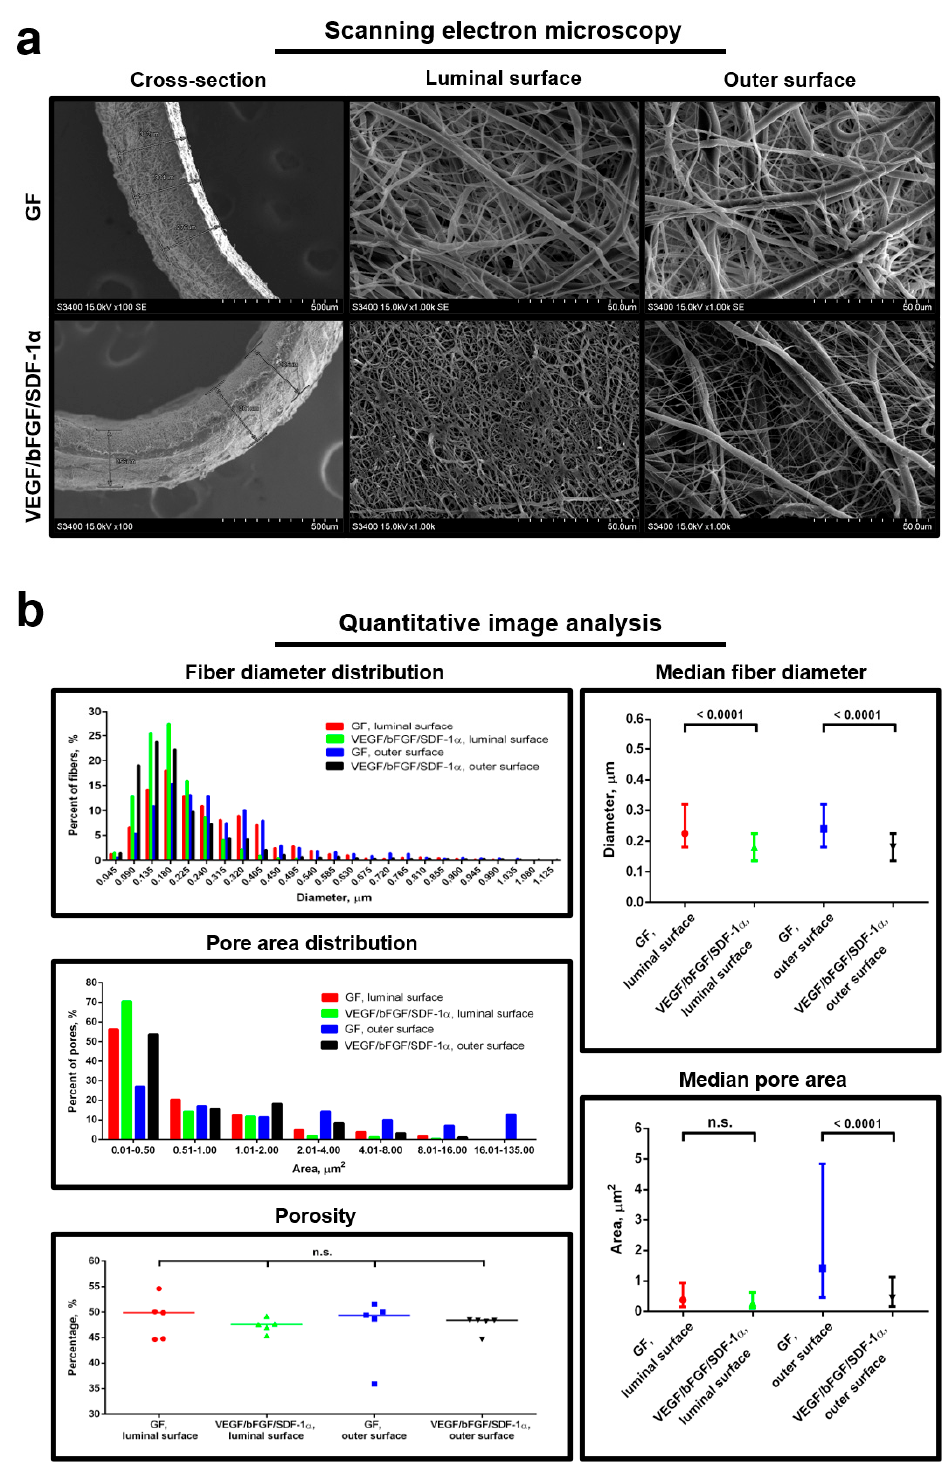
Figure 1. Two-layer structure of the grafts scales down the topography of the fibers and pores. ( a ) Pre-implantation representative scanning electron microscopy images of the grafts modified exclusively with either VEGF, bFGF or SDF-1 α (merged in GF group due to being one-layer), or with all three factors having a two-layer structure; ( b ) Quantitative image analysis (six images per group containing in total > 100 fibers and pores), data are represented as the median with interquartile range, Kruskal–Wallis test with the further Dunn’s multiple comparisons test, p values adjusted for multiple comparisons are reported in a numerical manner, n.s. is for not significant.